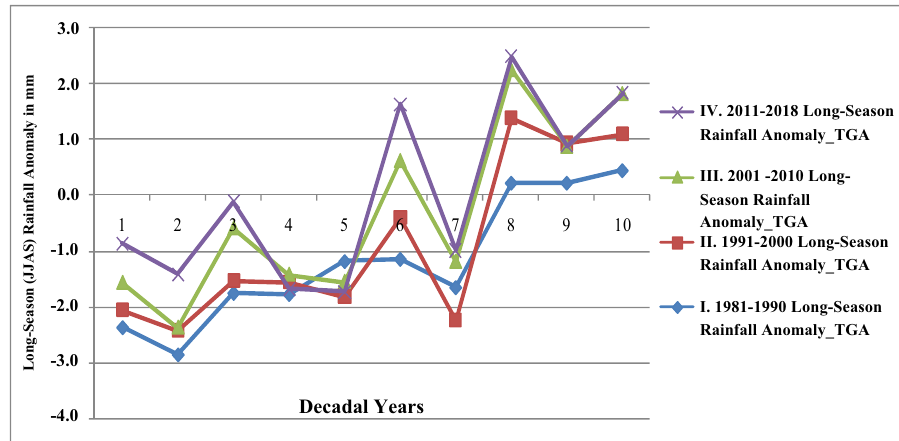
Figure 7: Decadal long - season rainfall anomaly in te ff growing